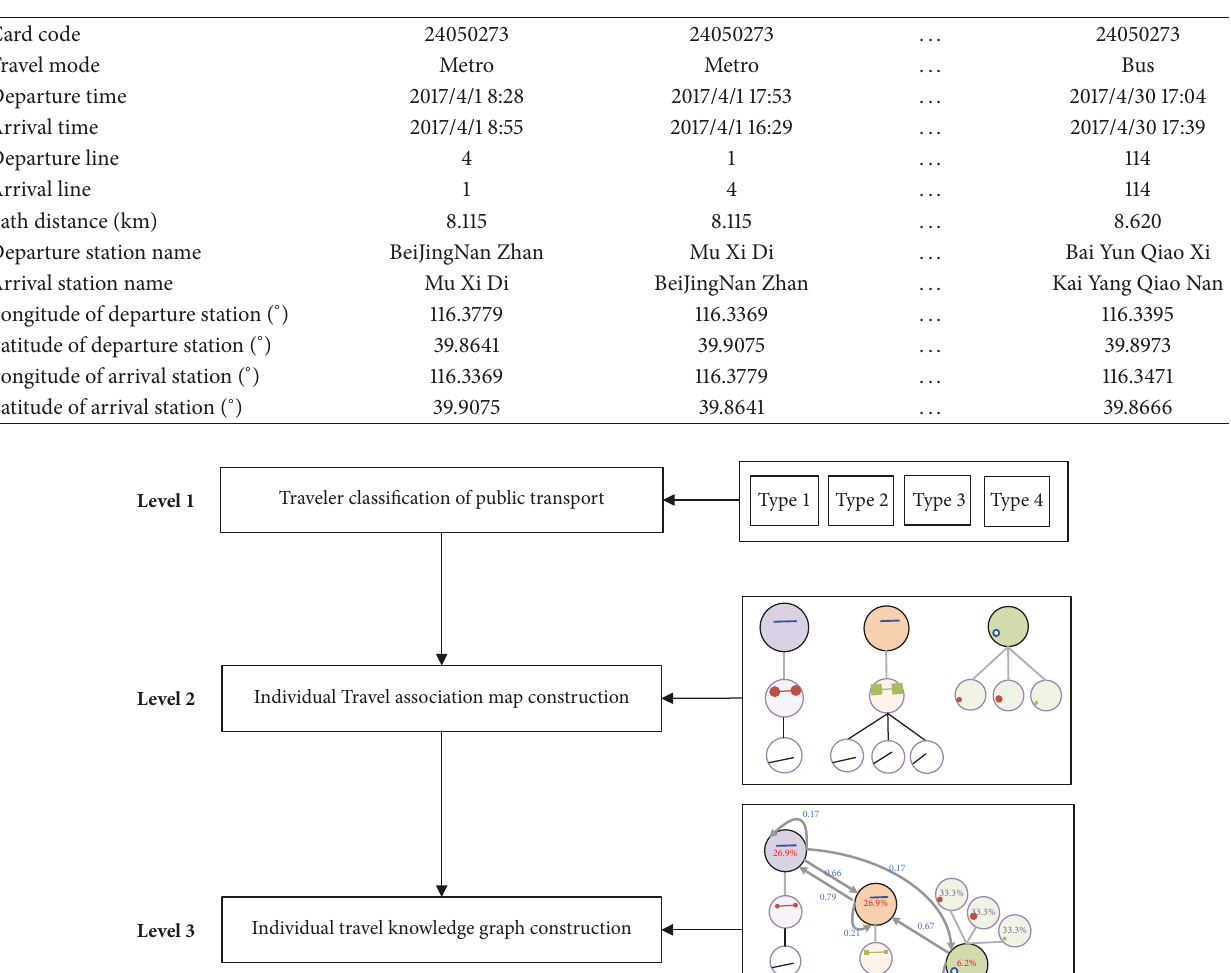
Table 3: Example of travel chain data of one passenger.